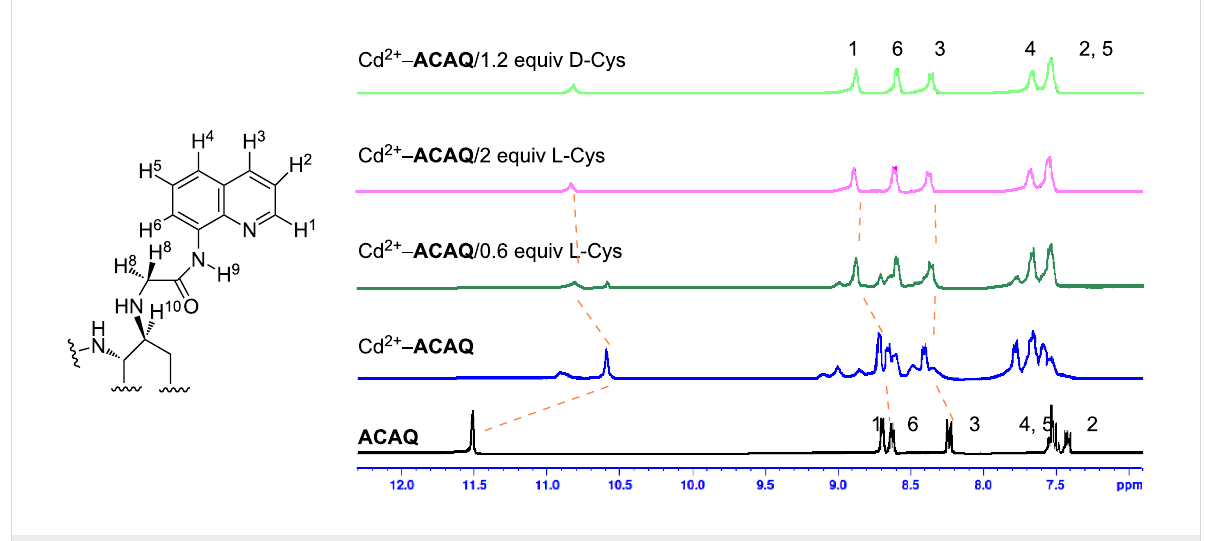
Figure 9: Partial 1 H NMR spectra (400 MHz) of ACAQ (5 mM) before and after the addition of Cd 2+ and then incremental addition of cysteine in DMSO- d 6 .